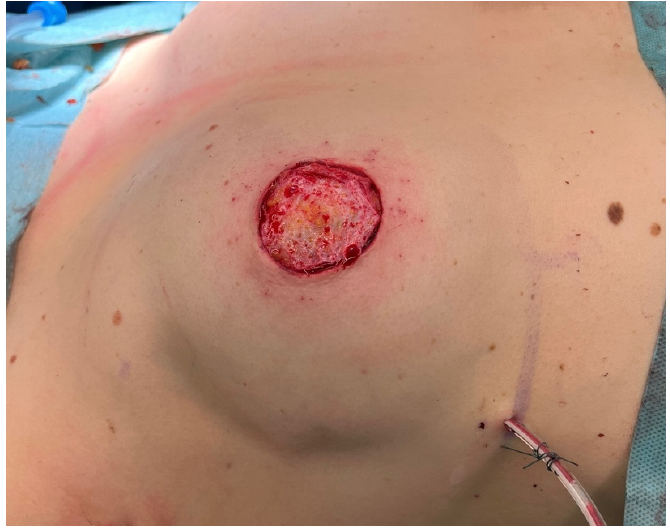
Figure 3. Mastectomy of the right breast (without ptosis) through a circumareolar incision. Inserted inner thigh flap through that incision. With an areolar ring that corresponds to the diameter of the previously harvested NAC, the position of the NAC is marked and then deepithelialized on the flap. The mastectomy flap is sutured to the dermis of the flap. The NAC is then grafted. Vertical skin resection can be determined as in a mastopexy by guiding the breast sideways in relation to the midline of the breast in the IMF. The NAC is harvested after marking with an areolar ring. The outer circle is now used as a mastectomy incision (for example, Figure 4). The cranial and caudal positions of the mastectomy skin in the midline of the breast are marked with a stapler to avoid distortion. The procedure is then performed as described above. The excess skin is gathered to the new NAC position according to the markings.